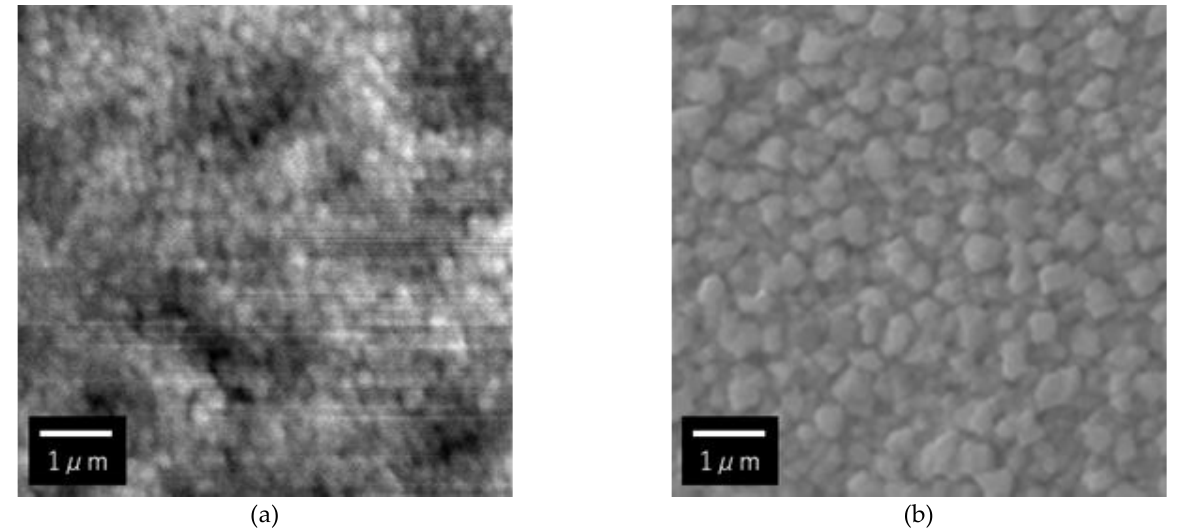
Figure 4. SEM (scanning electron microscope) image in ( a ) CH 3 NH 3 PbI 3 and ( b ) CH 3 NH 3 Pb(Cl,I) 3 with 25% Cl concentra- tion.